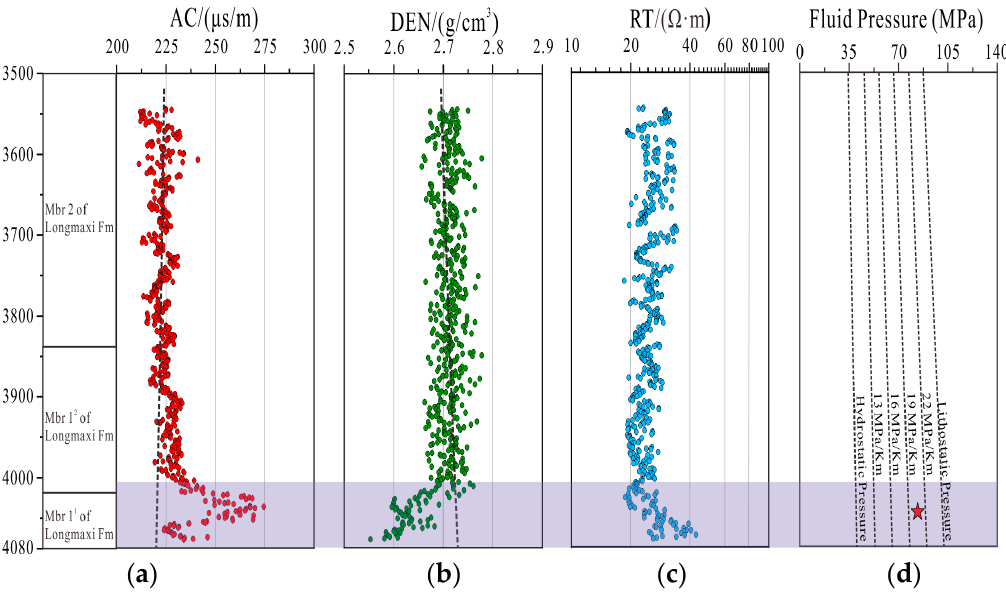
Figure 3. Comprehensive shale compaction curves of Well H-2, including ( a ) Acoustic transit time [AC], ( b ) Density [DEN], ( c ) Resistivity [RT], ( d ) Fluid pressure data from drill stem test (DST), indicating strong overpressure develops in the Mbr 1 1 of Longmaxi Fm shale. The red pentagram within ( d ) represents the measured fluid pressure of 81.63 MPa.